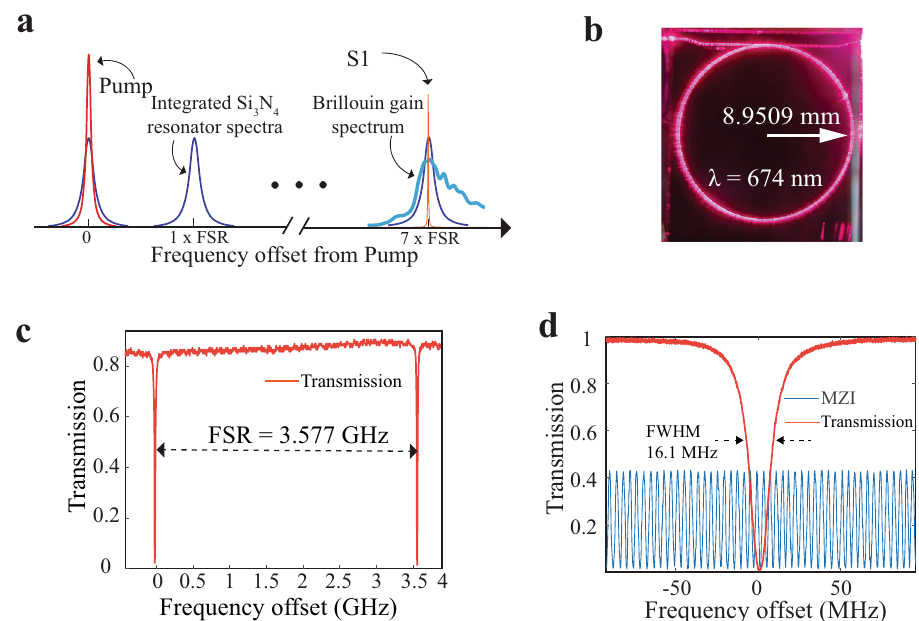
Fig. 3 Stimulated Brillouin scattering (SBS) resonator design, FSR and quality factor. a Resonator design with free-spectral range (FSR) = 3.587 GHz equal to 1/7 of the 25.110 GHz spontaneous Brillouin peak gain frequency shift. b Photograph of silicon nitride waveguide resonator illuminated with fi ber- coupled 674 nm laser light. The resonator radius is 8.9509mm. c Measured resonator free-spectral range (FSR) = 3.577 GHz at 674 nm. d Quality factor (Q) measurement (red trace) performed using radio frequency (RF) calibrated unbalanced Mach – Zehnder interferometer (MZI) (blue trace). Full width half maximum (FWHM) linewidth = 16.1 MHz loaded Q = 27.7 million and intrinsic Q = 55.4 million and loaded Q = 27.7 million at 674